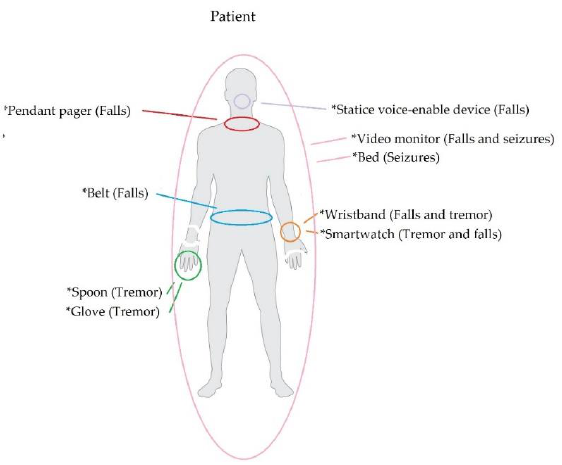
Figure 2. Types of wearable devices and the impairments that they are typically used to detect.